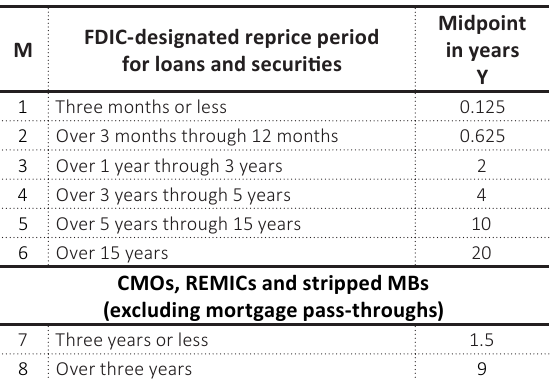
Table 1. FDIC-determined reprice